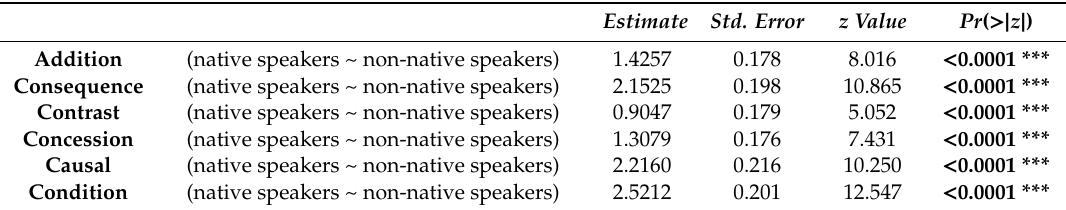
Table 5. Di ff erences of score in the main task between native and non-native speakers per relation. Estimate Std. Error